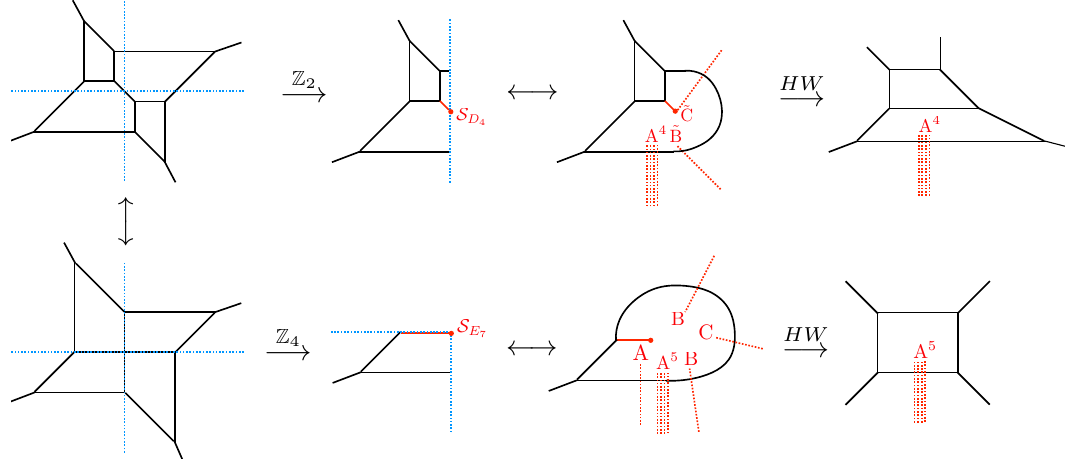
Figure 25 . S-folds of a rank-4 non-Lagrangian theory called “Pinwheel theory”. The Z 2 quotient (top) gives rise to the SU(3) + 4 F theory, and the Z quotient (bottom) leads to the SU(2) + 5 F 2 4 theory. Here, we used a different resolution of an O 7 − as e B = [3 , − 1] and e C = [1 , − 1] = B so that the S is attached to the internal (1 , − 1) D 4